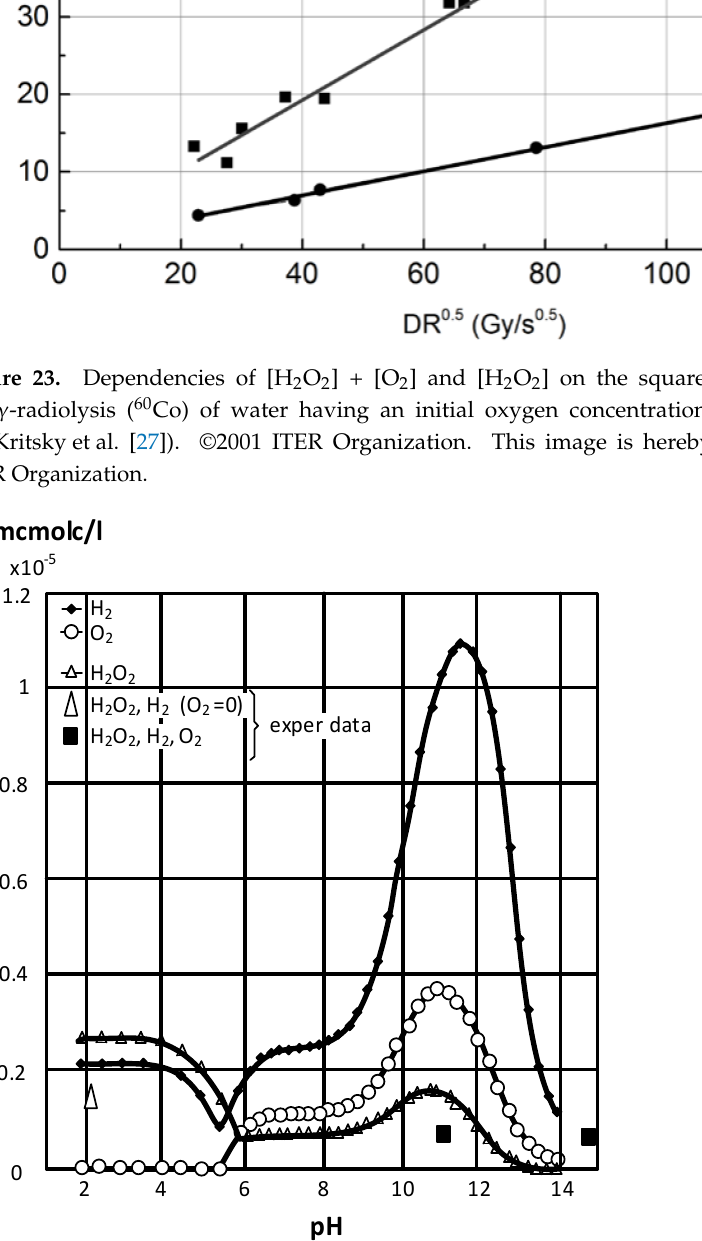
Figure 24. Predicted vs. experimental dependencies of the concentrations of H 2 , O 2 , and H 2 O 2 on pH (after Kritsky et al. [27]). © 2001 ITER Organization. This image is hereby used courtesy of the ITER Organization.